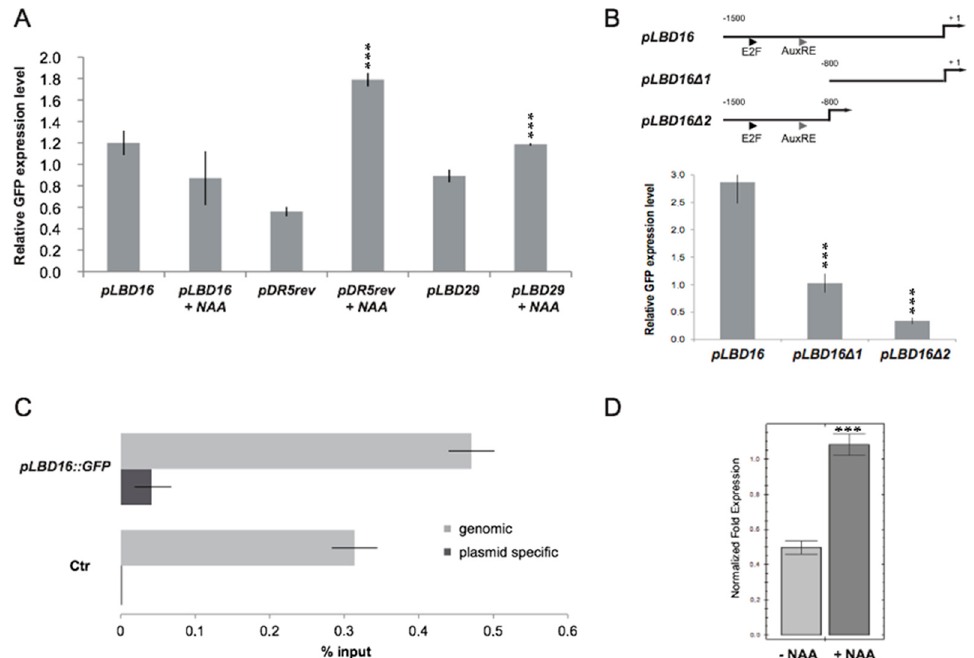
Figure 6. The LBD16 promoter-reporter construct shows high and auxin-independent activity in Arabidopsis protoplasts. ( A ) GFP protein expression levels in suspension derived protoplasts treated with or without 10 μ M NAA expressing